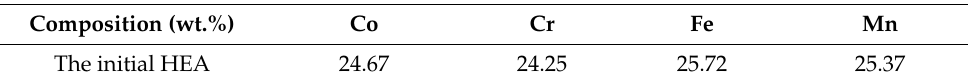
Figure 1. EDS results of the initial HEA. Table 1. Chemical composition of the HEA.